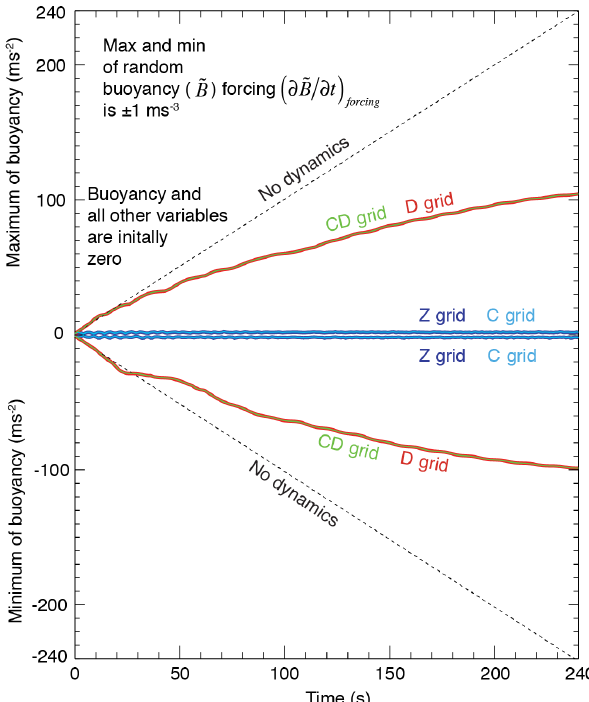
Figure 14. Time change of the maxima and minima of buoyancy ( e B) for the Z-, C-, D- and DC-grid simulations in the presence of noisy heating patterns. The thin dashed line indicates the time change when the response of vorticity and divergence is turned